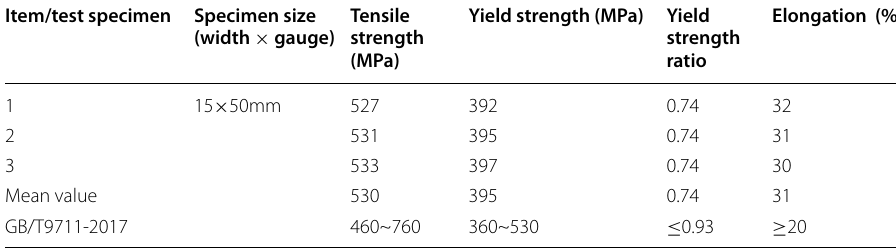
Table 5 Results of tensile